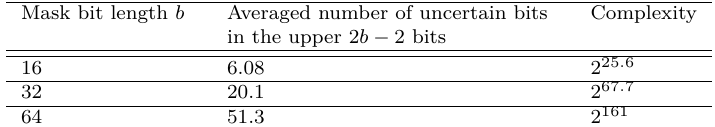
Table 4: Complexity of proposed attack using 10-out-of-20,000 cache